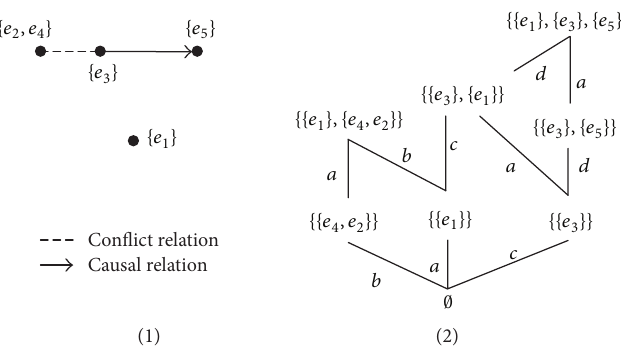
Figure 10: Symmetric quotient model of E : E 𝐺